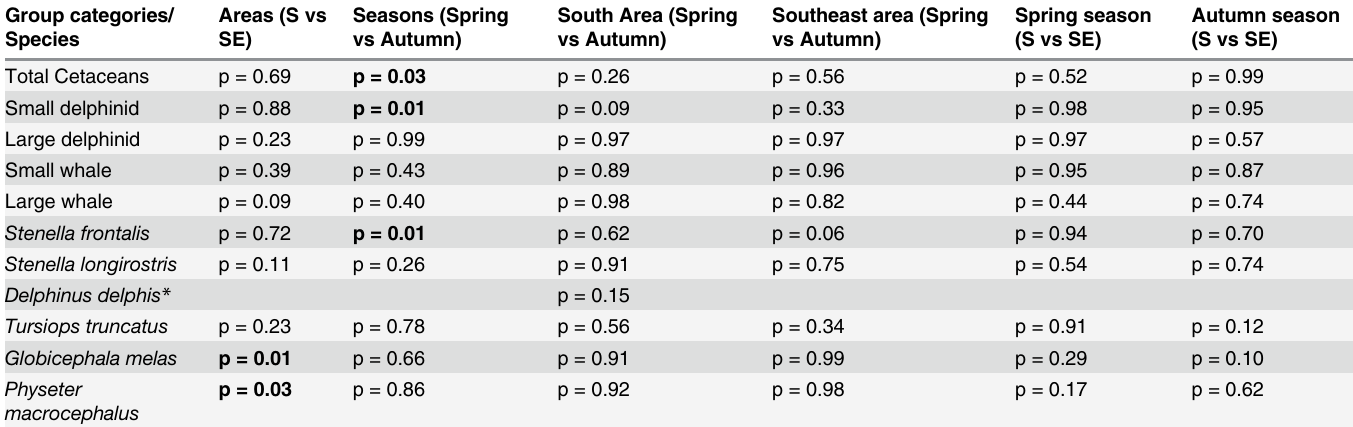
Table 6. ANOVA and post-hoc Tukey tests results of ER comparisons between areas south and southeast and seasons. Group categories/